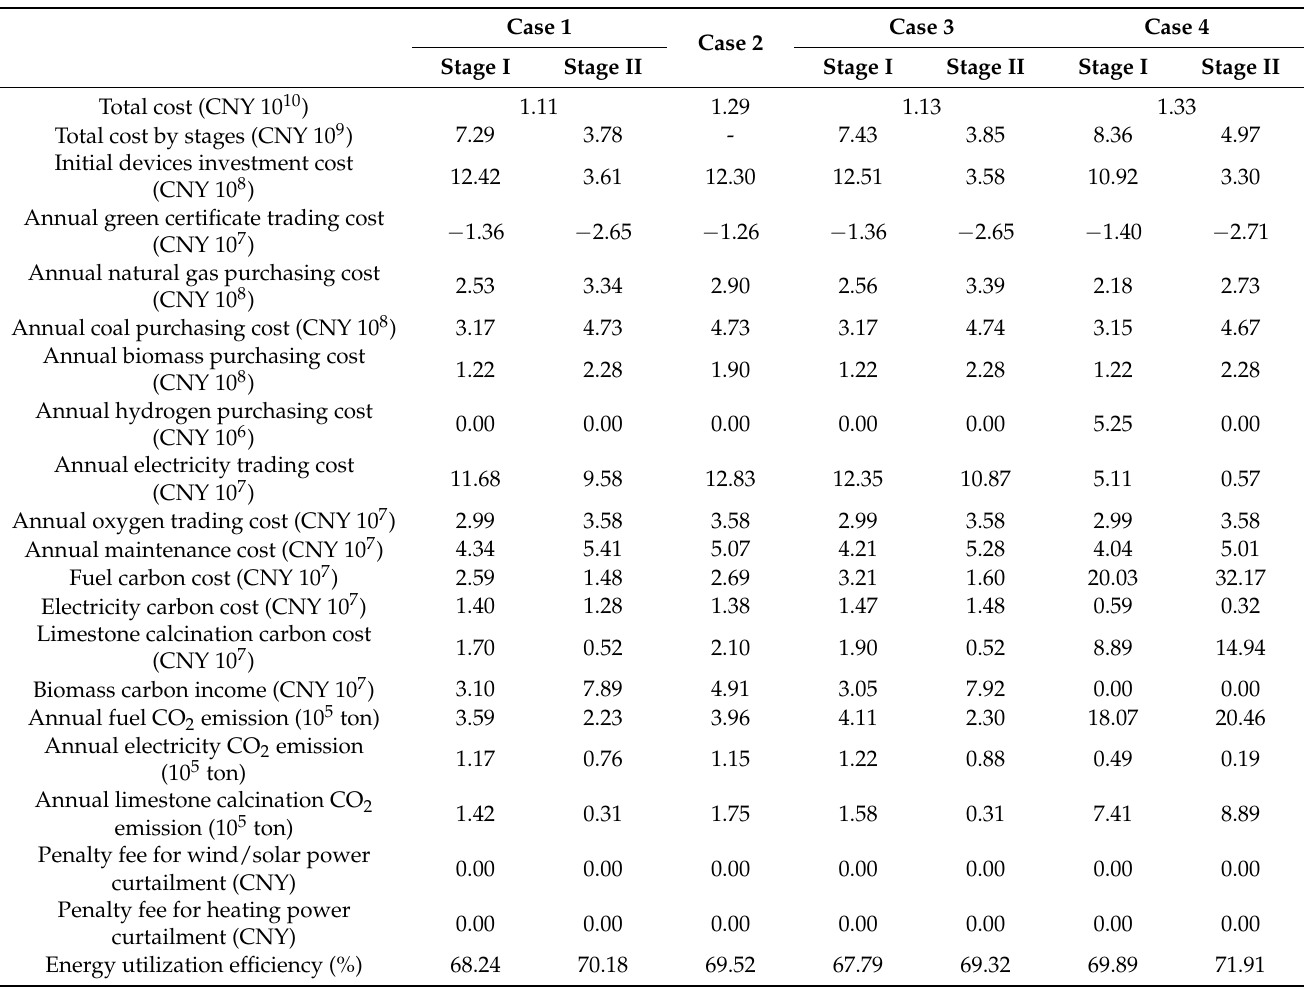
Table 1. Comparison of Case Results: Cost and